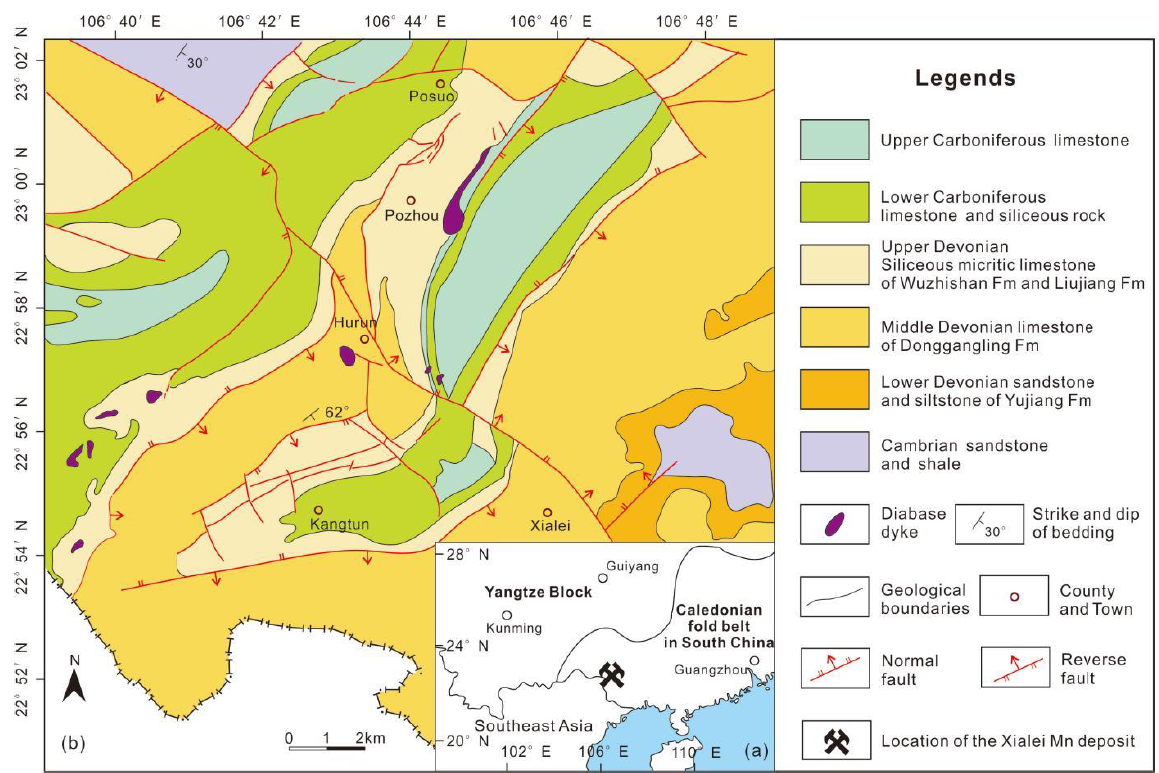
Figure 1. ( a ) Location and regional geological setting of the Xialei Mn Deposit (modified after [16]); ( b ) detailed geological map of the Xialei Mn deposit (modified after [17]).